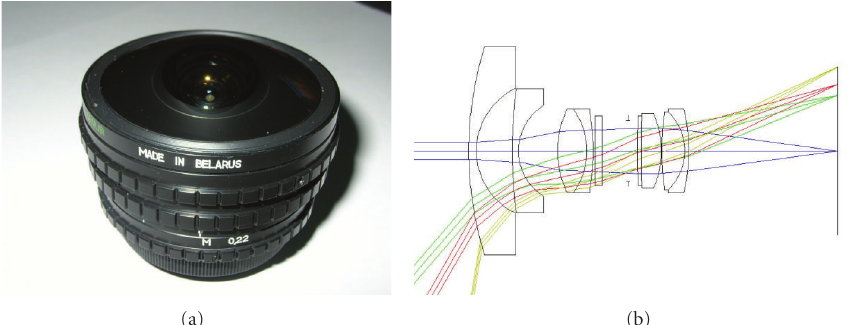
Figure 2: The picture and the schema of the used Peleng fish-eye lens. It should be noted that the lens consist of 10 glass elements. Although no detailed measurements about spectral e ffi ciency of the lens, by analogy with similar lenses, one can expect that there will be no or very little response below 400 nm.